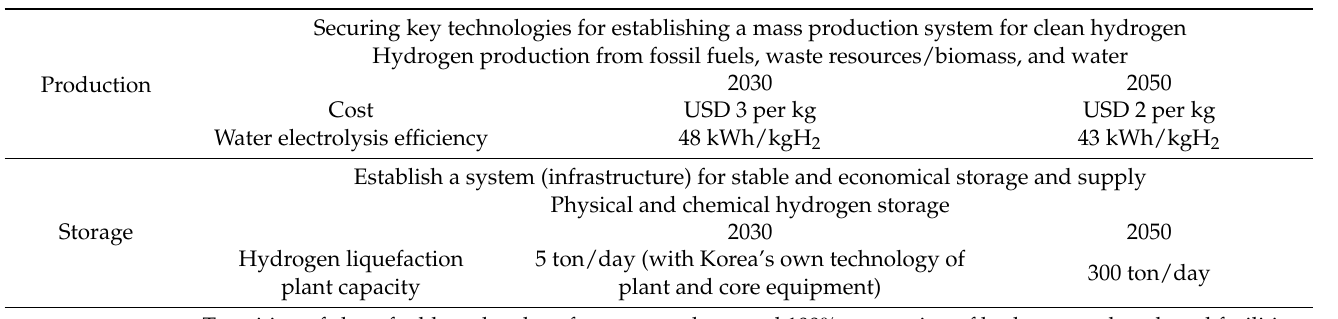
Table 6. Korea’s hydrogen technology and economy strategies by value chain from Korea’s hydrogen technology development roadmap 2.0